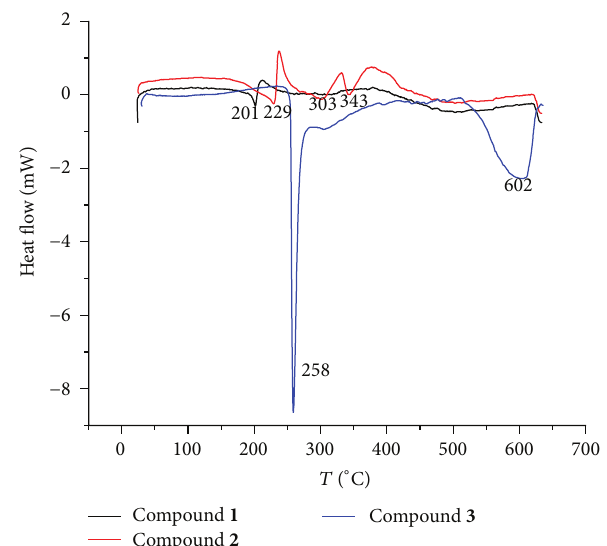
Figure 3: The DSC curves for compounds 1 – 3 .